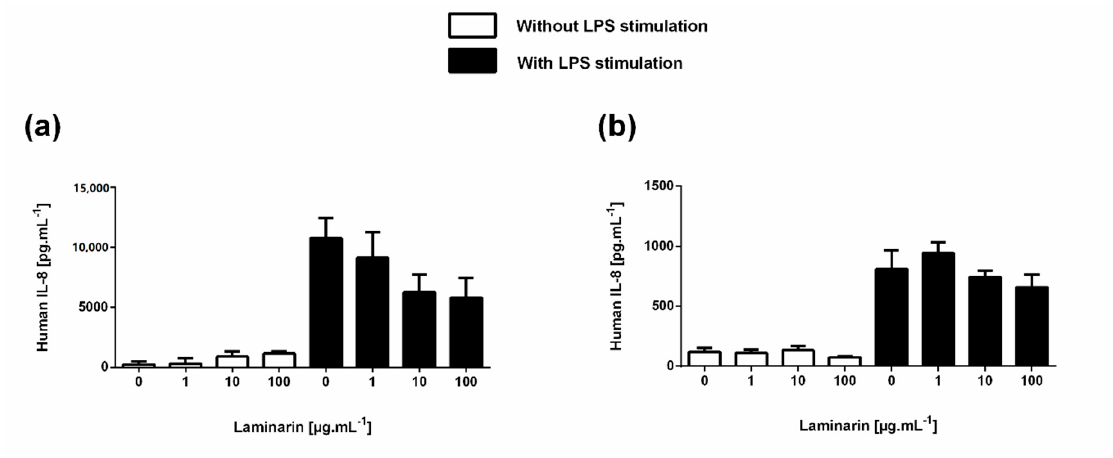
Figure 9. Quantitative analysis of IL-8 cytokine with an ELISA kit. ( a ) HDFa and ( b ) NHEK cells were stimulated with 1, 10 and 100 µg.mL − 1 laminarin for 24 h (HDFa cells) and 48 h (NHEK cells) in the absence or in the presence of LPS at 10 µg.mL − 1 . An ELISA assay was performed to quantify the level of IL-8 cytokine secreted in cell culture medium supernatant. Data are expressed as mean ± SD of two independent experiments.